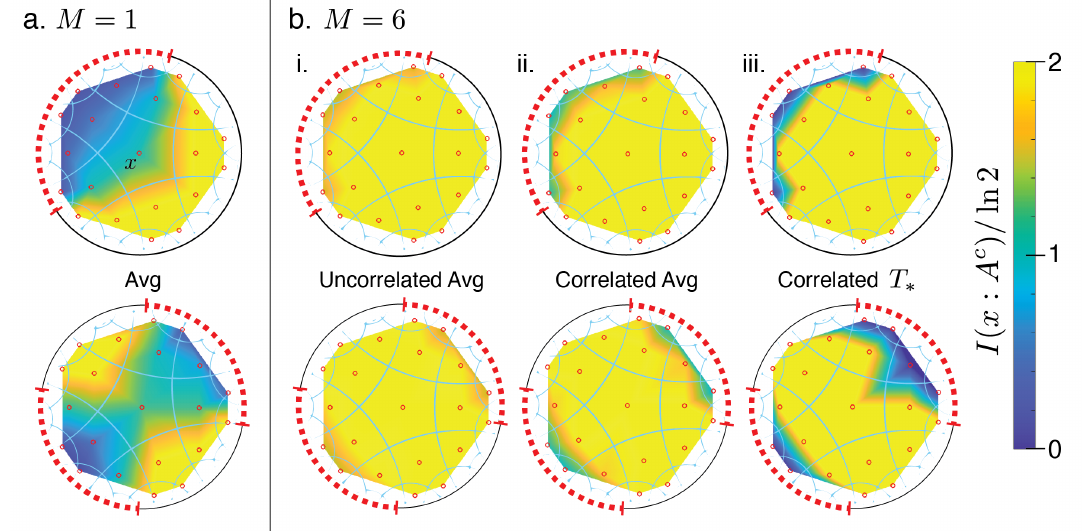
Figure 18 . Bulk information retained by the depth M = 1 HaPPY code (a) versus the depth M = 6 concatenated HaPPY code stack (b) after projectively measuring (dotted red) a single contiguous region A (top row) or a pair of diametrically opposed regions A = A (bottom row). 1 ∪ A 2 In the depth M = 6 stack we have some control over the ETW brane tension by choosing the local measurement bases to be classically correlated between the different layers in the stack. Completely uncorrelated random measurement bases (i) leave the bulk largely intact when averaged over 100 samples. We interpret this situation as analogous to a holographic geometry cut off by an ETW brane with near-critical tension T → T . By contrast, measuring all M legs in the same basis (ii,iii) c tends to be more destructive of the bulk. Sampling over 100 of these stack-correlated measurement bases yields lower-tension branes that tend to destroy more of the bulk (ii). Finally, we search over all such stack-correlated measurement bases to find the most destructive measurement basis (iii), which corresponds to some finite minimal tension 0 < T . From these experiments it is clear ∗ < T c that both the stack depth M as well as the choice of measurement basis play an essential role in determining the ETW brane tension T . Here we use | A | = 24 for the contiguous region (top) and | A 1 | = | A 2 | = 15 for the pair of opposing regions